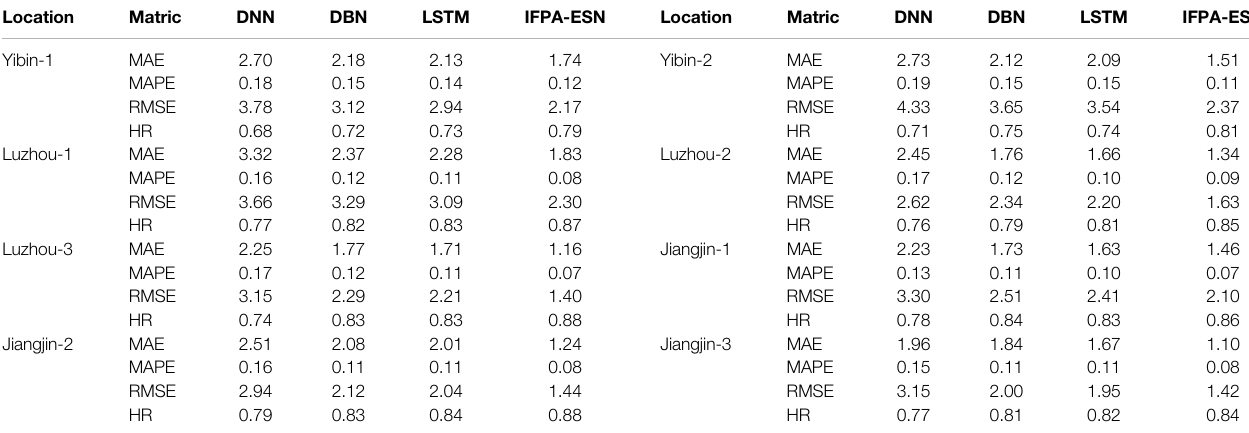
TABLE 6 | Nitrate concentration prediction with decomposition approach. Location Matric